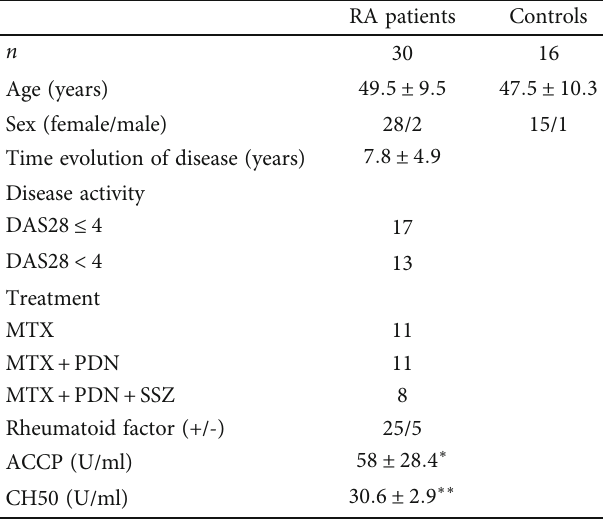
Table 1: Characteristics of patients with rheumatoid arthritis and healthy controls included in the